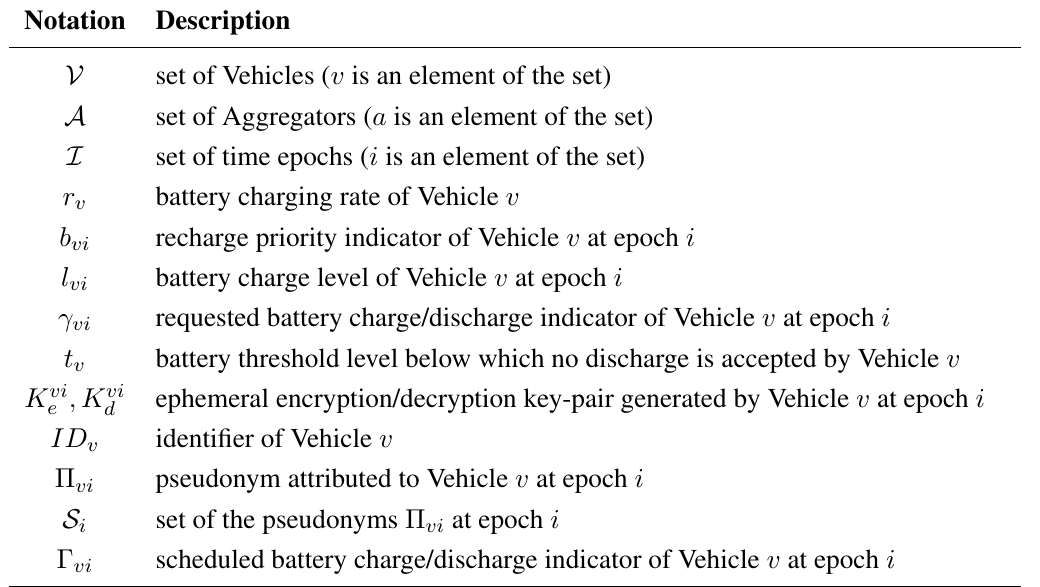
Table 1. List of main